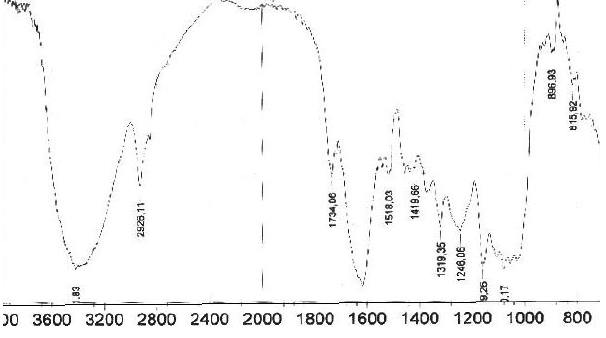
Figure 1 . FTIR spectrum of cinnamon.